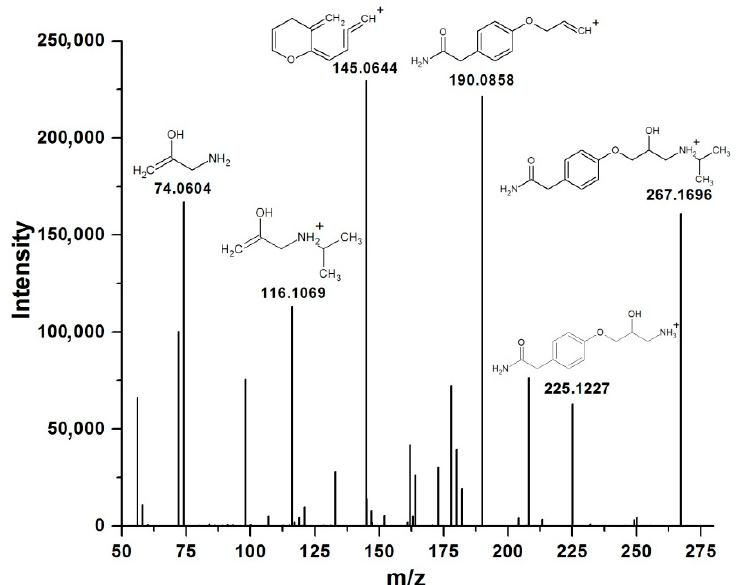
Figure 2. The mass spectrum of atenolol as registered by the PRM method. Masses of fragment ions of atenolol are identified.